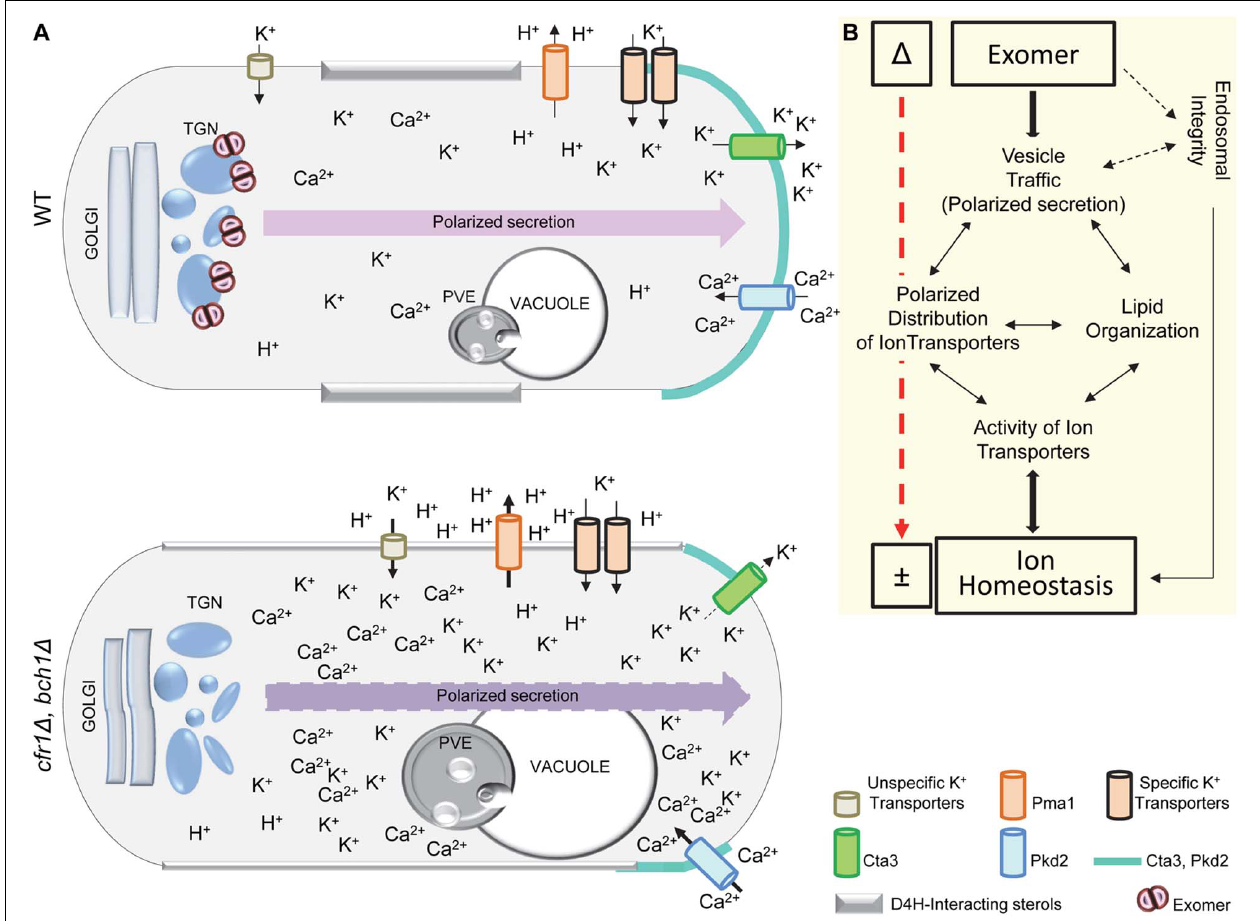
FIGURE 9 | Schematic overview of the phenotypes observed in exomer mutants. (A) The cartoon in the upper panel (WT) represents a wild-type cell, and the cartoon in the lower panel ( cfr1 (cid:49) , bch1 (cid:49) ) represents an exomer mutant cell. In the mutant, there were alterations in the morphology of the Golgi, trans -Golgi network (TGN) (Hoya et al., 2017) and the prevacuolar endosome (PVE), in the polarized secretion and distribution of Cta3 and Pkd2, and in the distribution of some lipids. The ATPase Pma1 was hyperactive, resulting in plasma membrane (PM) hyperpolarization. PM hyperpolarization and abnormal Cta3 activity would result in enhanced K + influx—probably through unspecific transporters—and reduced K + efflux, leading to increased K + accumulation. The abnormal distribution and/or activity of Pkd2—and maybe other Ca 2 + channels—would result in increased calcium influx and accumulation. Thick arrows denote ion fluxes that would be enhanced in the mutant with respect to the WT, and the thin dashed arrow denotes fluxes that would be reduced. Some phenotypes were enhanced in the presence of KCl, and others were only observed under these conditions. (B) Interplay between the processes involved in the maintenance of ion homeostasis in wild-type cells. Exomer participates in vesicle traffic and facilitates polarized secretion that results in polarized distribution of ion transporters and in an adequate lipid organization in the PM. The polarized distribution of ion transporters and the adequate lipid organization modulate each other, guaranteeing adequate vesicle traffic, and resulting in proper activity of ion transporters. Additionally, exomer is required for the integrity and/or morphology of endosomes, either because of its regulation of vesicle transport or because of some unknown function (dashed arrows). Endosomal integrity is required for vesicle trafficking; therefore, it influences polarized secretion. Moreover, endosomes participate in the maintenance of intracellular ionic gradients and, therefore, their integrity is required for ion homeostasis. In exomer mutants ( (cid:49) ), the coordination between these processes is altered (red dashed arrow), leading to abnormal ion homeostasis ( ±